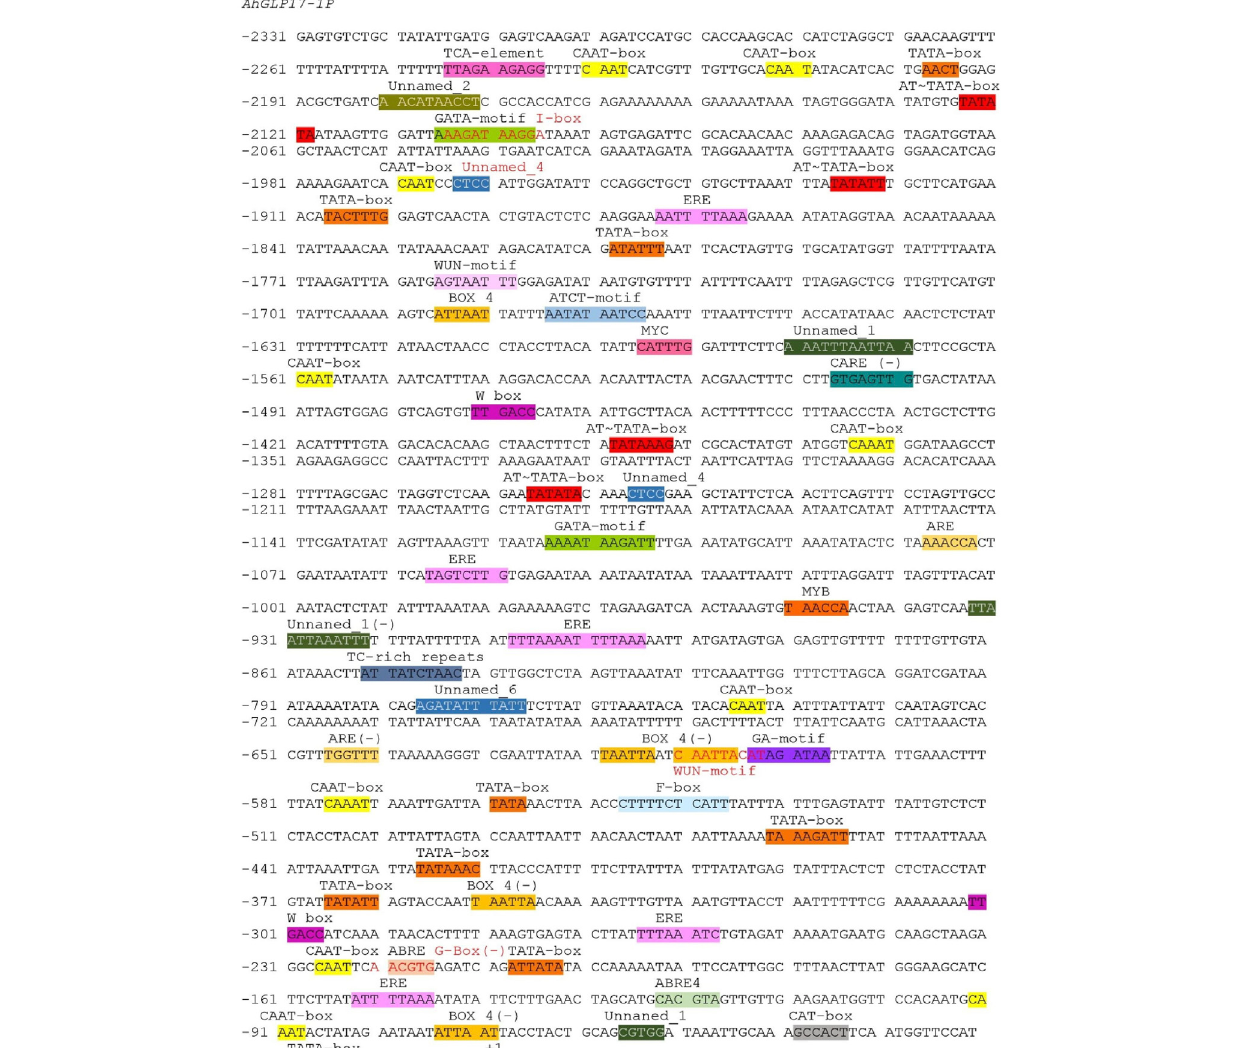
Frontiers in Genetics |